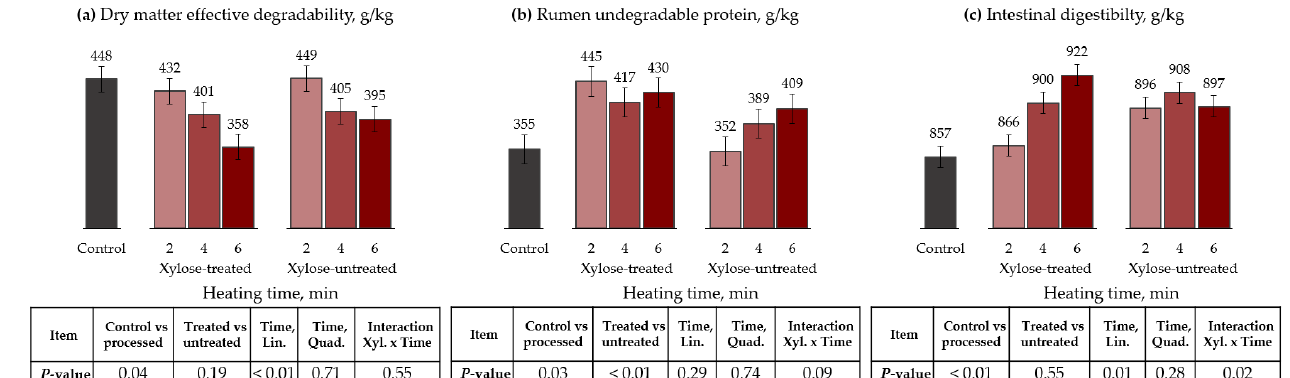
Figure 3. Effects of microwave-oven heating and xylose treatment on dry matter effective degradabil-